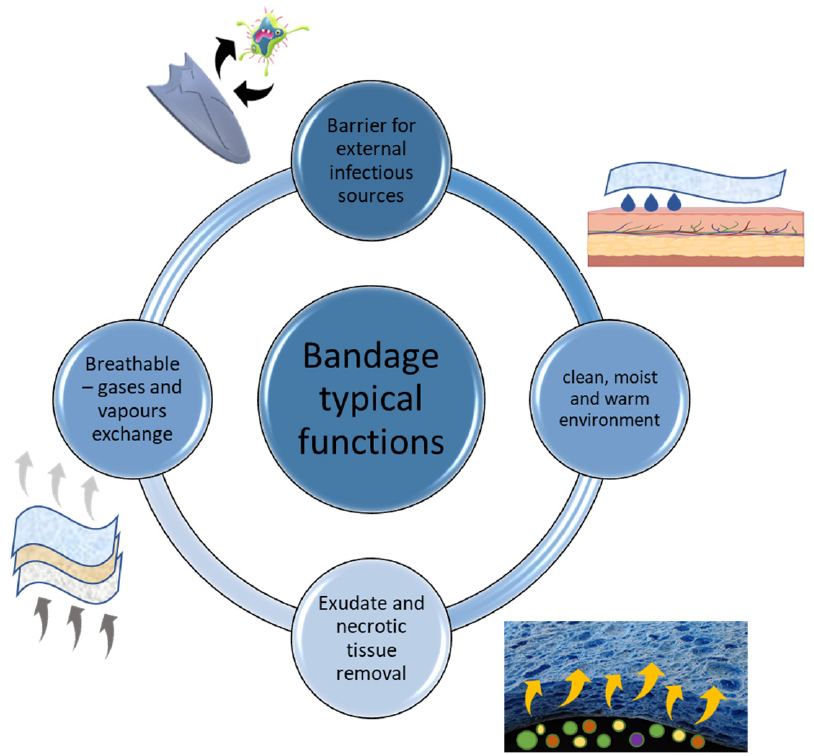
Figure 5. The main functions of the typical bandage for the improved wound-healing process.